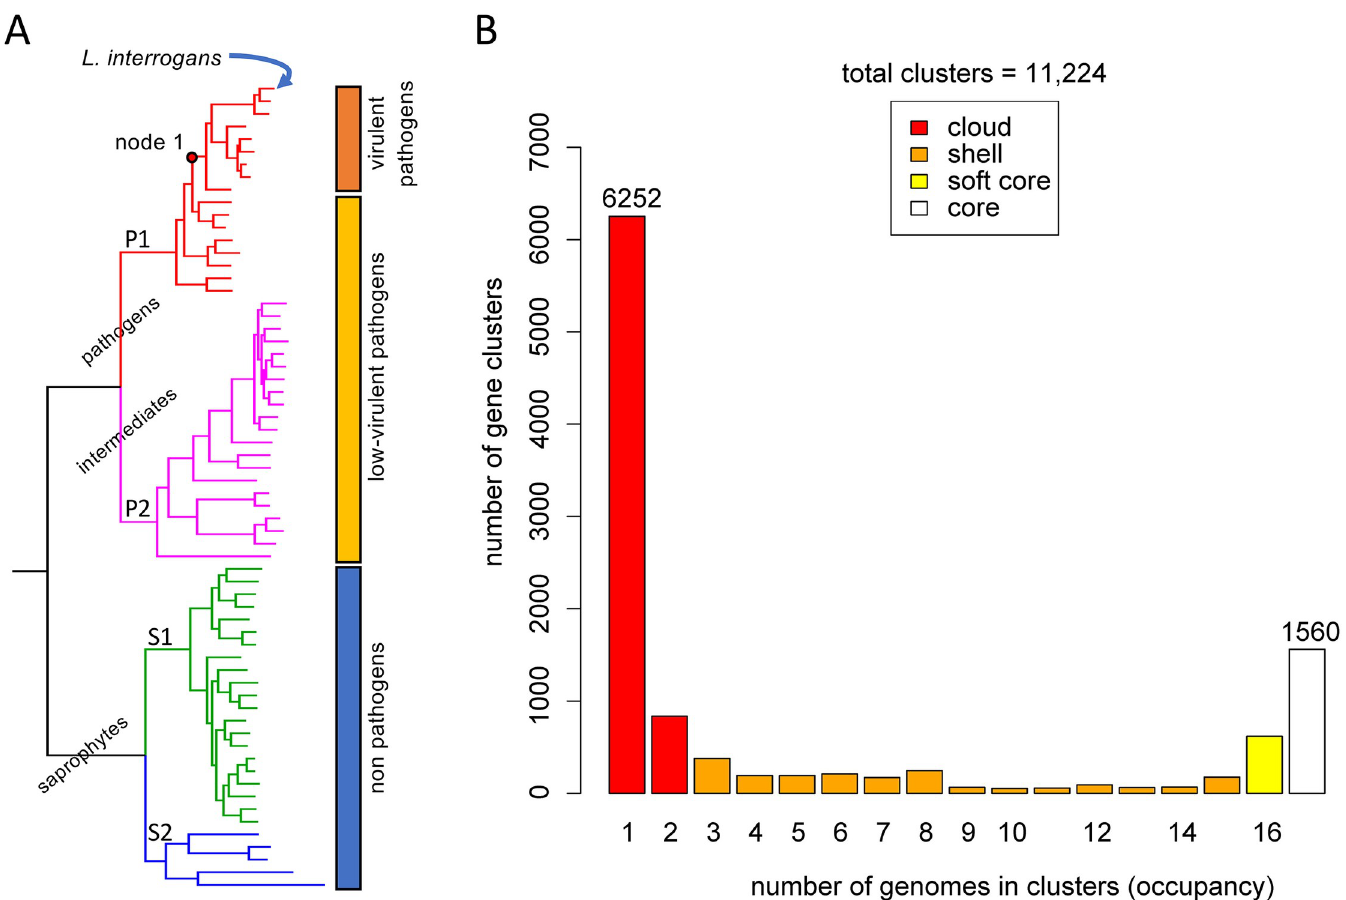
Fig 2. Massive species diversity. (A) Phylogenetic tree showing the relatedness of the 64 Leptospira species. Leptospira species are clustered as non-pathogens, low- virulent pathogens, and virulent pathogens according to their virulence status in animal models, prevalence in severe infections, and presence of virulence factors. Node 1 indicates the node from which descend pathogenic species are most frequently involved in human disease. (B) Distribution of gene clusters in the P1 clade revealing an open pan-genome with a relatively high number of gene clusters found only in a single species. Adapted from Vincent and colleagues [5].